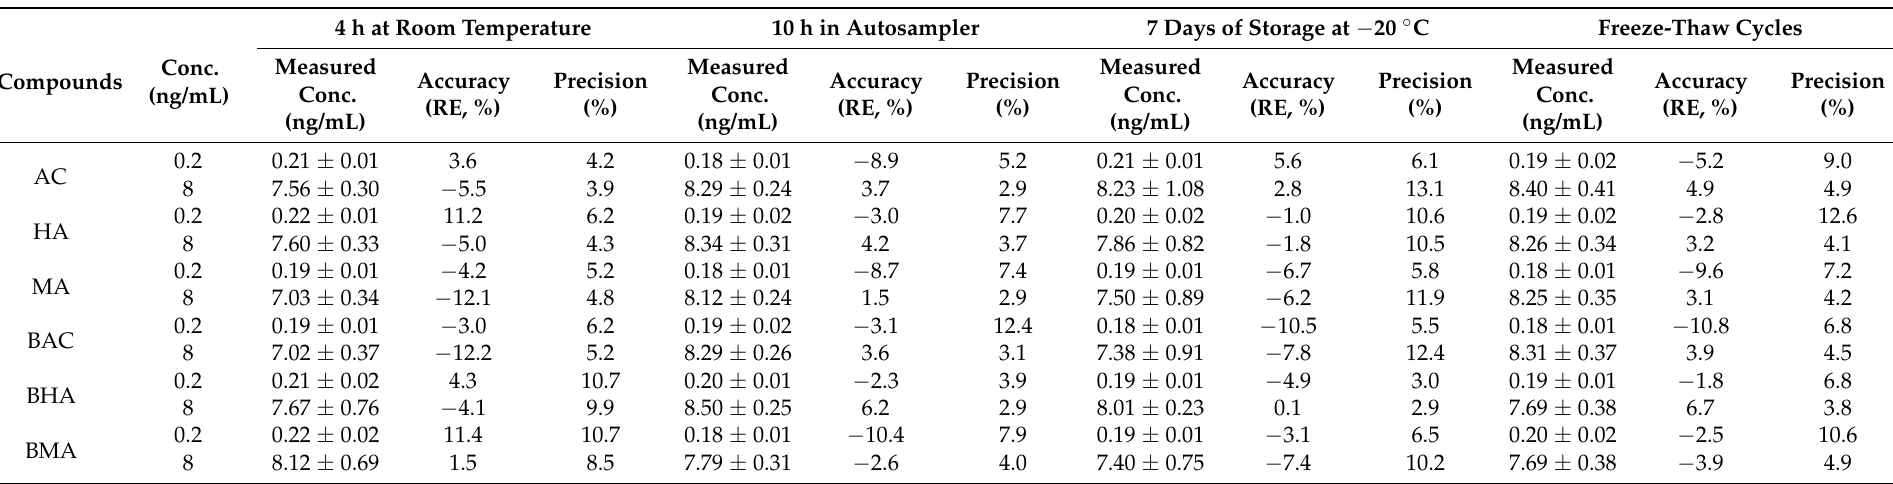
Table 3. Stability of the developed methods ( n =